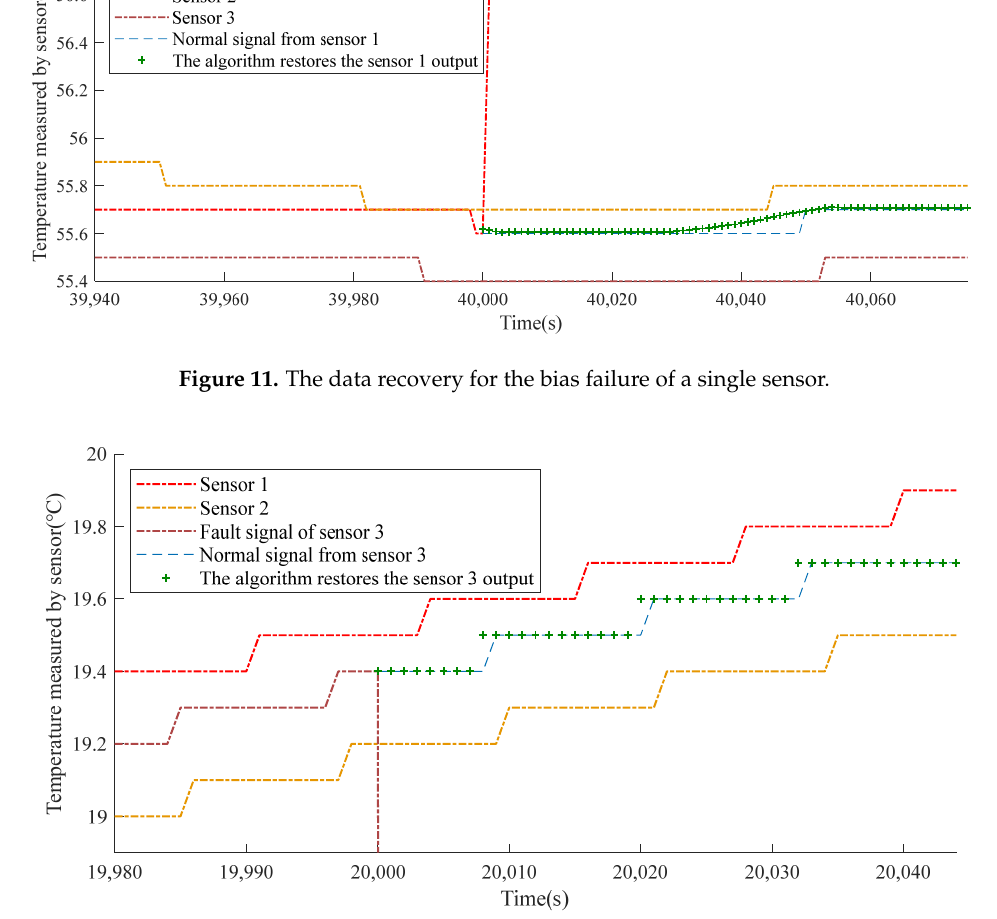
Figure 12. The data recovery for the power failure of a single sensor.